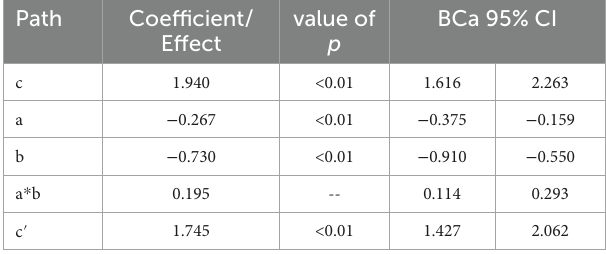
TABLE 4 Mediation analysis